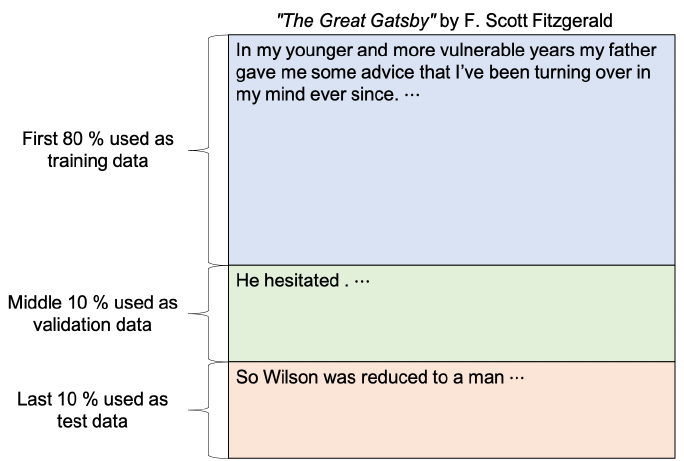
Figure 3. How to split text for each novel into training, validation, and test